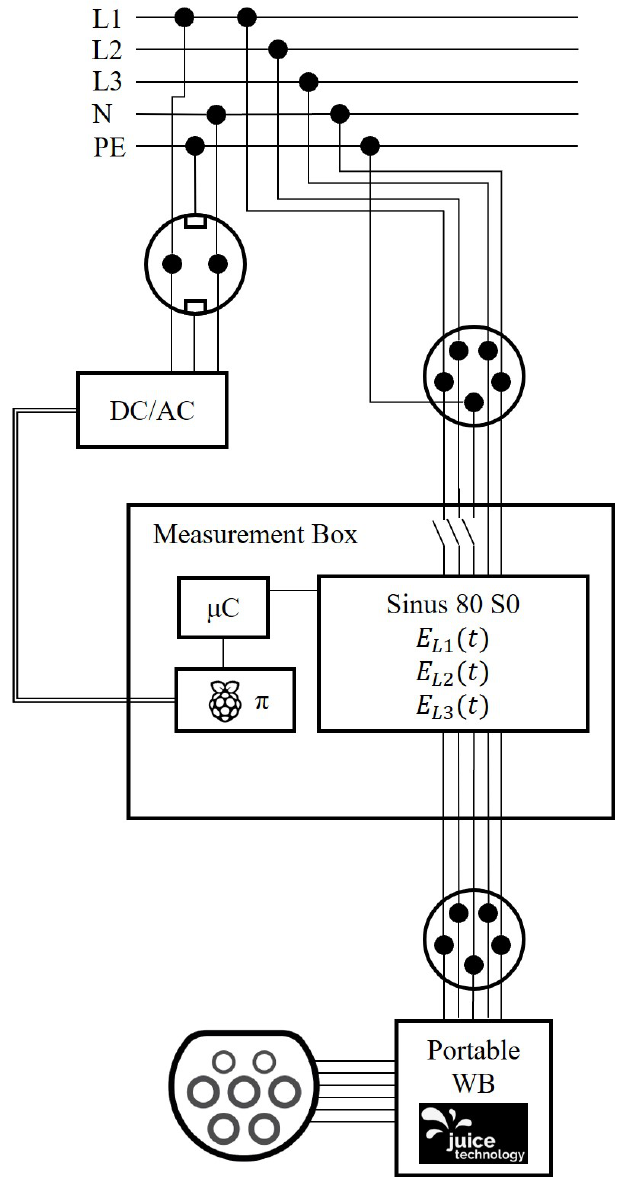
Figure 4. General overview measuring